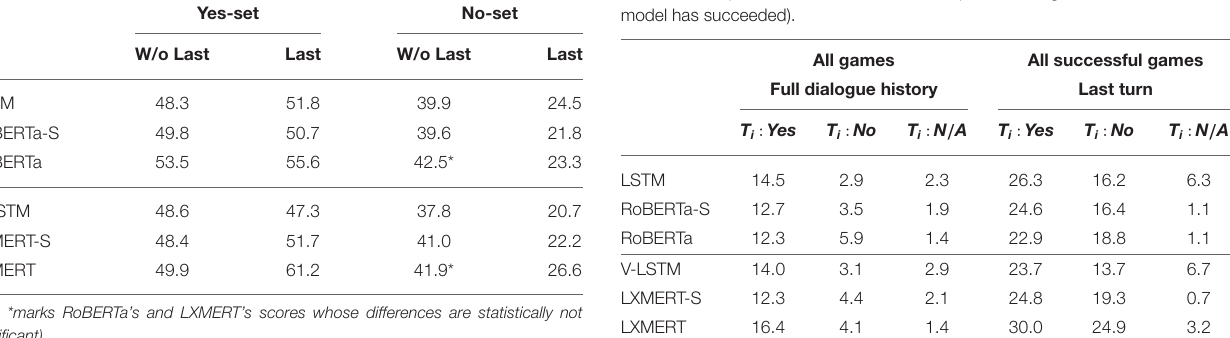
TABLE 3 | Full test set: Accuracy comparison when giving to the model the dialogue without the last turn (W/o Last) or with only the last turn (Last). Yes-set